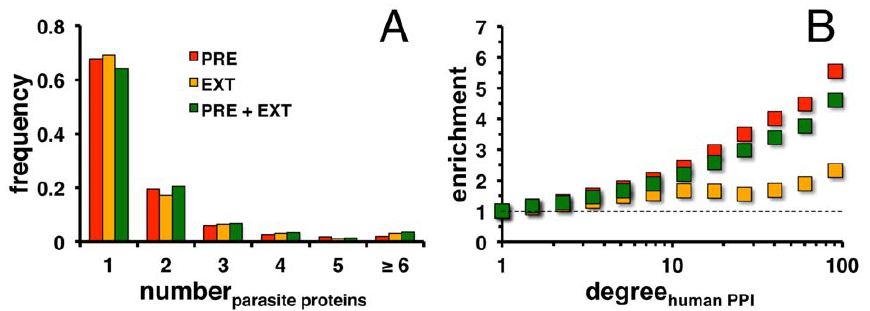
Figure 3. Characteristics of predicted and external interactions. ( A ) In the set of predicted interactions (PRE) a majority of host proteins interacted with a low number of pathogen proteins and vice versa. Such a result was confirmed by the set of external interaction data (EXT) as well as the combined set of host-parasite interactions (PRE + EXT). ( B ) Utilizing a network of human protein-protein interactions the enrichment of targeted human host proteins as a function of their number of interaction partners was determined. Considering all three sets of host-pathogen interactions separately highly connected host proteins appeared to be prime targets of the parasite.